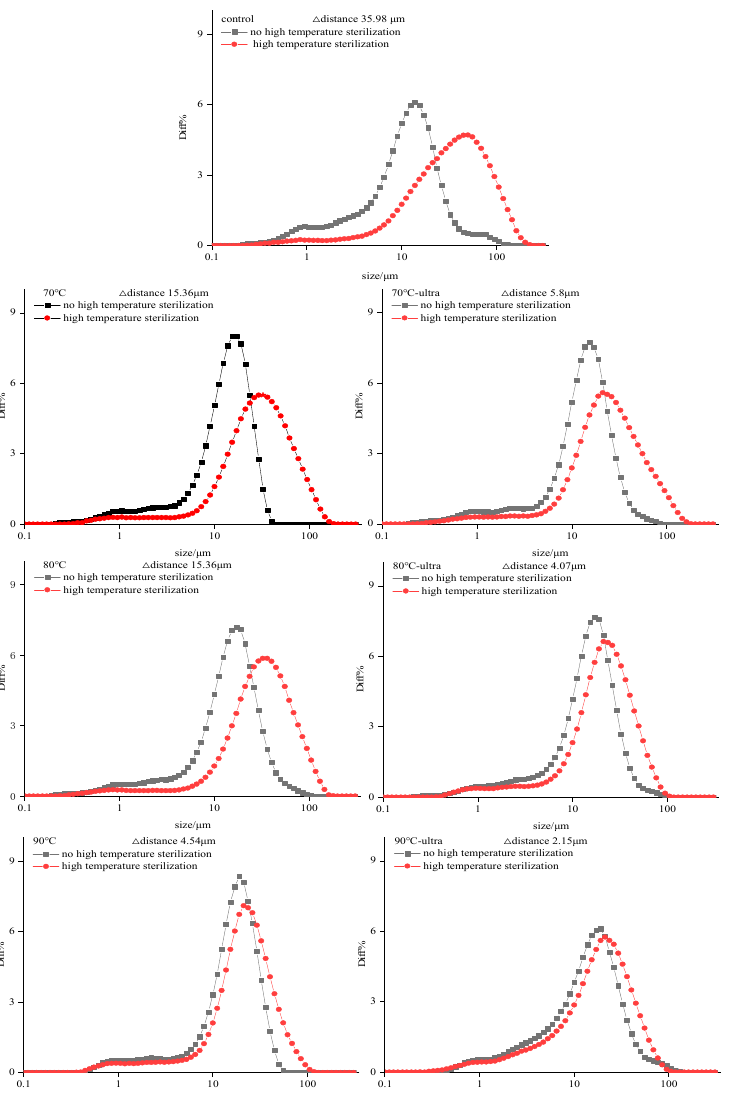
Figure 8. Particle size distribution curve of different coconut milk samples before and after thermal treatment (ultra: 53 kHz, 40 w / l , 20 min; 70, 80 and 90 °C represent preheating for 20 min; high ‐ temperature sterilization: 135 °C for 60 s).